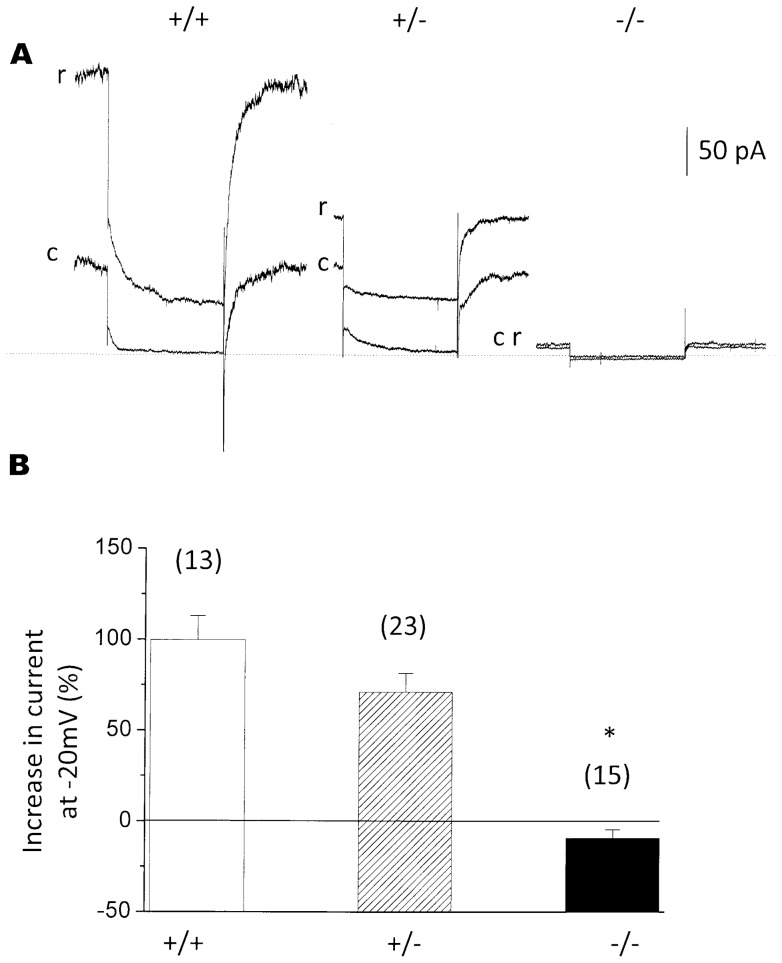
Retigabine (r) enhances M-current in KCNQ2+/+ and +/− neurons but not in KCNQ2−/− neurons.
A. Sample current records. Control, (c); 10µM retigabine, (r). Calibration: pA total current. Note that retigabine slows current deactivation and accelerates current activation as previously observed [25]. B, Mean % increase in standing outward current at −20 mV in +/+, +/− and −/− neurons (with numbers of neurons in brackets). *- indicates significant difference from wild type (P<0.01).